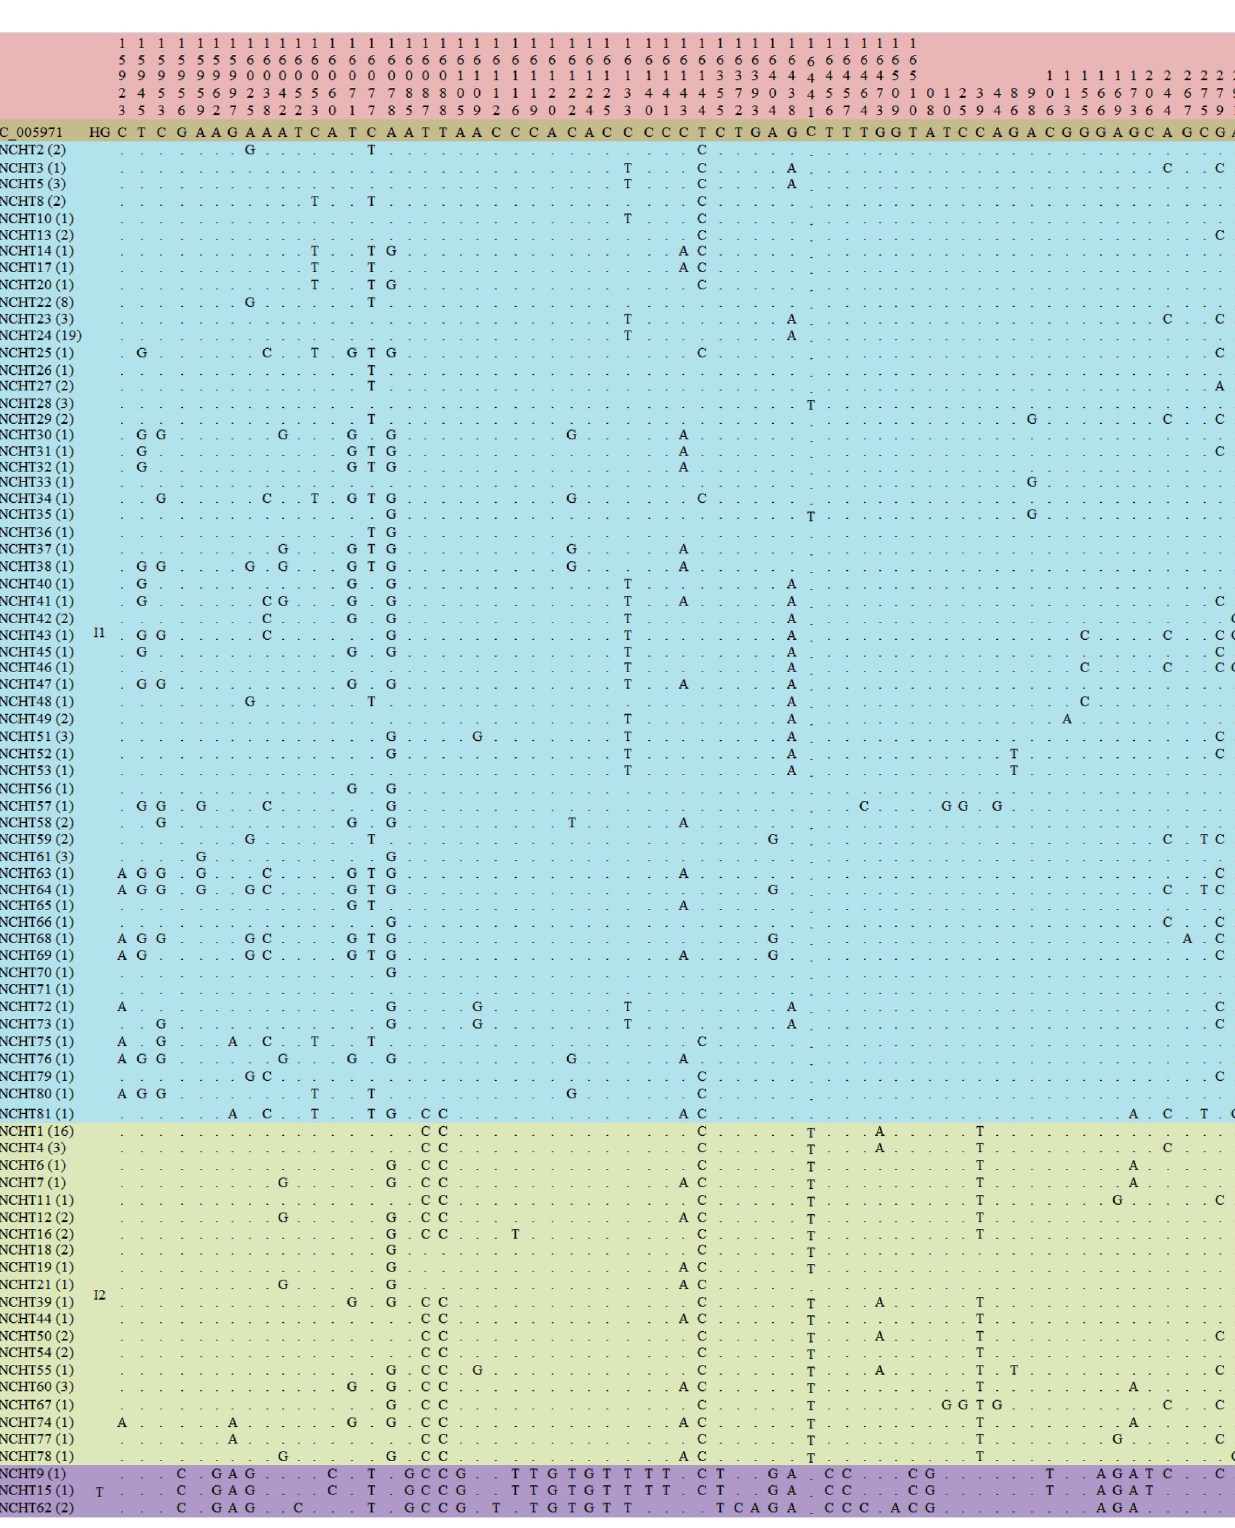
Fig 2. Sequence variation observed among Andaman cattle haplotypes (ANCHTs) with Bos indicus (Zebu cattle) reference sequence (NC_005971) [46]. The sequence information of ANCHTs were aligned with NC_005971 using 913 bp sequence information (bp 15795–16341,1–366). Only variable sites are shown. The sequence positions of every variable sites are indicated above. Dots (.) indicate identity with the reference sequence and different base letters denote substitution. HG indicates Haplogroup. Haplogroups were traced by anunrooted neighbor-joining tree (Fig 3). https://doi.org/10.1371/journal.pone.0278681.g002 PLOS ONE | https://doi.org/10.1371/journal.pone.0278681 December9, 2022 6 /